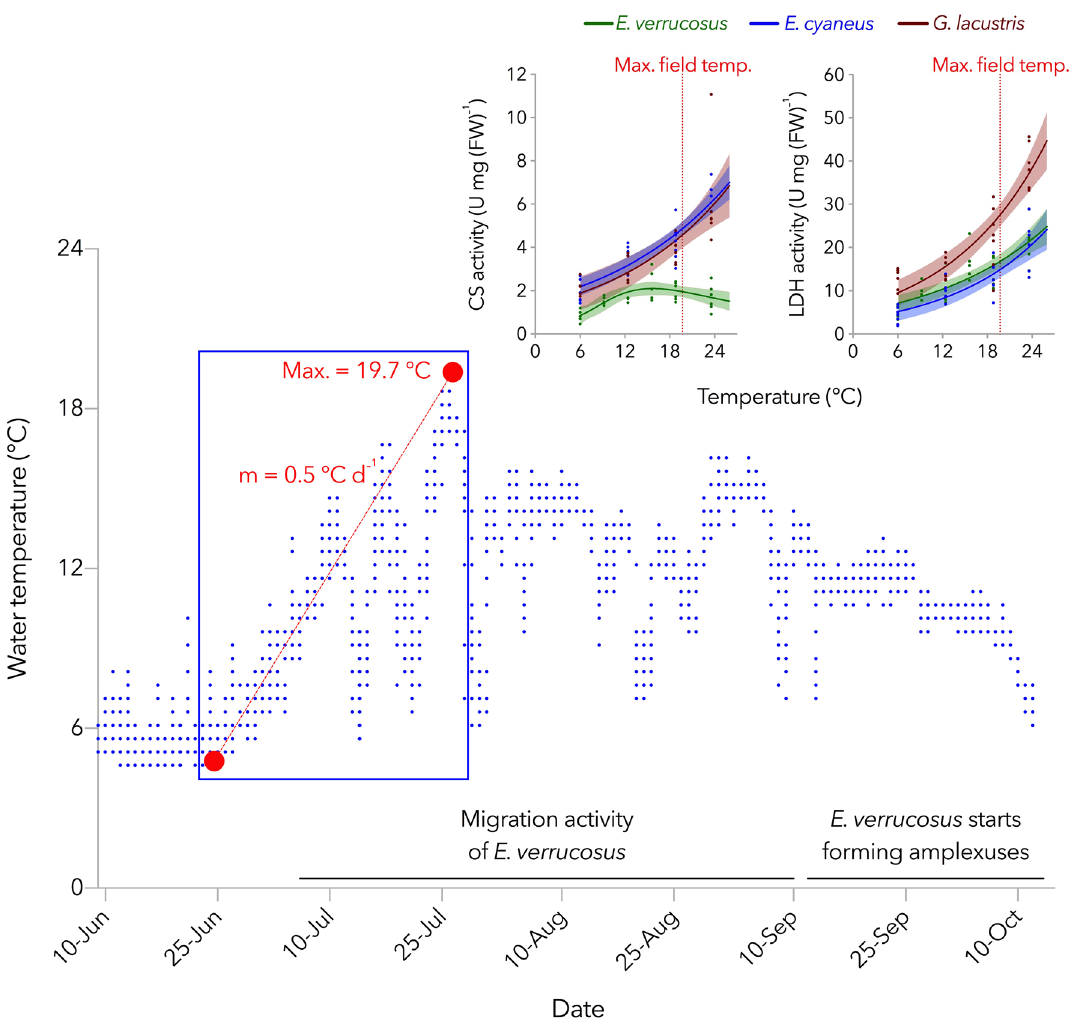
Figure 6. Water temperature in Lake Baikal (Bolshie Koty) at 1 m depth. The temperature was determined with an iButton Temperature Logger (Maxim Integrated, USA) deployed in the benthic zone, every hour from the 9 th of June until the 10 th of October 2019 (resolution: 0.5 °C). Small panels in the upper right corner show activities of citrate synthase (CS, as indicator of aerobic capacity) and lactate dehydrogenase (LDH, as indicator of anaerobic capacity) measured in E. verrucosus (stenothermal, Lake Baikal endemic), E. cyaneus (eurythermal, Lake Baikal endemic), and G. lacustris (eurythermal, Lake Baikal endemic) along an experimental thermal gradient (0.8 °C per day) in relation to maximum field temperature. Maximum activities of aerobic key metabolic enzymes (e.g., CS) fail to increase steadily with temperature over the entire natural thermal range in the stenothermal E. verrucosus , while they increase with temperature over the entire thermal range in E. cyaneus and G. lacustris . Instead, LDH increases exponentially with temperature in all species over the entire thermal range. Migration of E. verrucosus to deeper waters was indicated by decreasing abundances in the upper littoral when temperatures increased in tion (22.9–25.2 °C for E. cyaneus and about 23.6 °C for G. lacustris ) and ventilation (19.1–20.8 °C for E. cyaneus and 21.1–21.8 °C for G. lacustris ) 12 (Fig. 5), clear differences in metabolic thermal responses were found in this study. The findings of uncompensated metabolic activities as well as higher capacities of mitochondria (i.e., COX), fatty acid metabolism and anaerobic glycolysis in G. lacustris than in E. cyaneus indicate differences in temperature-dependent movement activity. First, species with high locomotor activity rates may show increased cristae surface areas per unit of mitochondrial volume and consequently high COX/CS ratios 50 . Second, the high need for sustained swimming was shown to be indicated by high aerobic capacities and efficient energy produc- tion through fatty acid metabolism 51 . Third, species with a high need for immediate movement responses, e.g., needed for escaping predators, were shown to have high anaerobic capacities 52 . As the three overarching tasks, to find food, escape predators, and reproduce, are controlled by associated encounter rates, natural selection will favor the most beneficial locomotor activity 53 . The observed differences in the two eurythermal amphipod spe- cies’ metabolic performance may thus be explained by specific habitat features and different lifestyles.